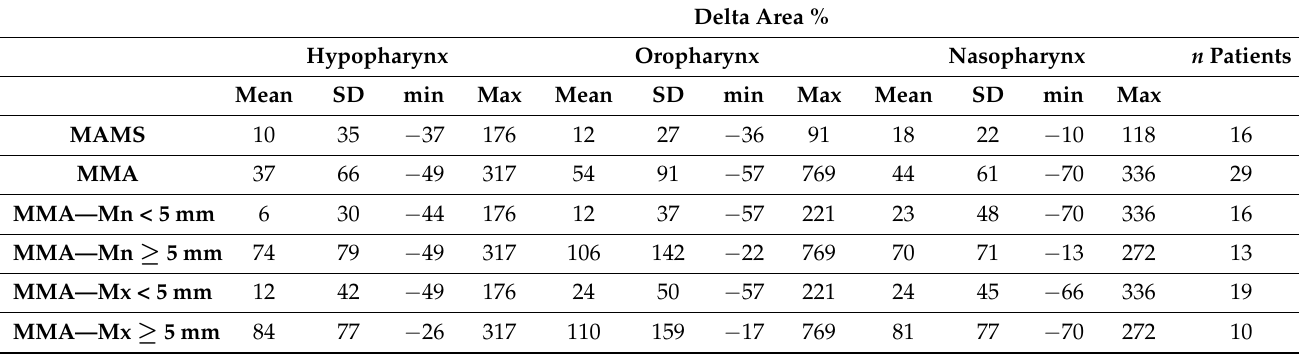
Table 2. Descriptive statistics of ∆ Area of UA slices in each considered subgroup, tabulated by